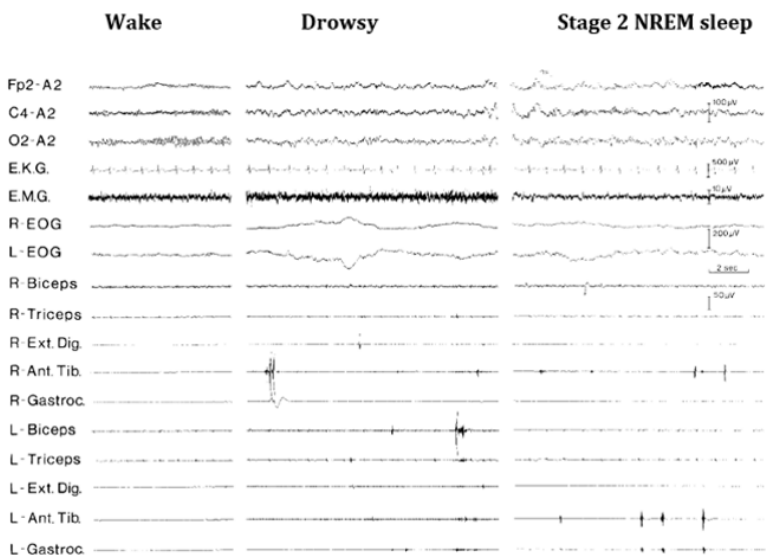
Figure 27. Excessive fragmentary myoclonus in a 42 ‐ year ‐ old complaining of daytime fatigue and drowsiness. The myoclonus which appears clinically as fasciculations occurs in drowsiness (middle PSG sample) and NREM sleep (right PSG sample) occurs bilaterally and independently in different areas of the body. (Permission to reproduce granted by Cambridge University Press).